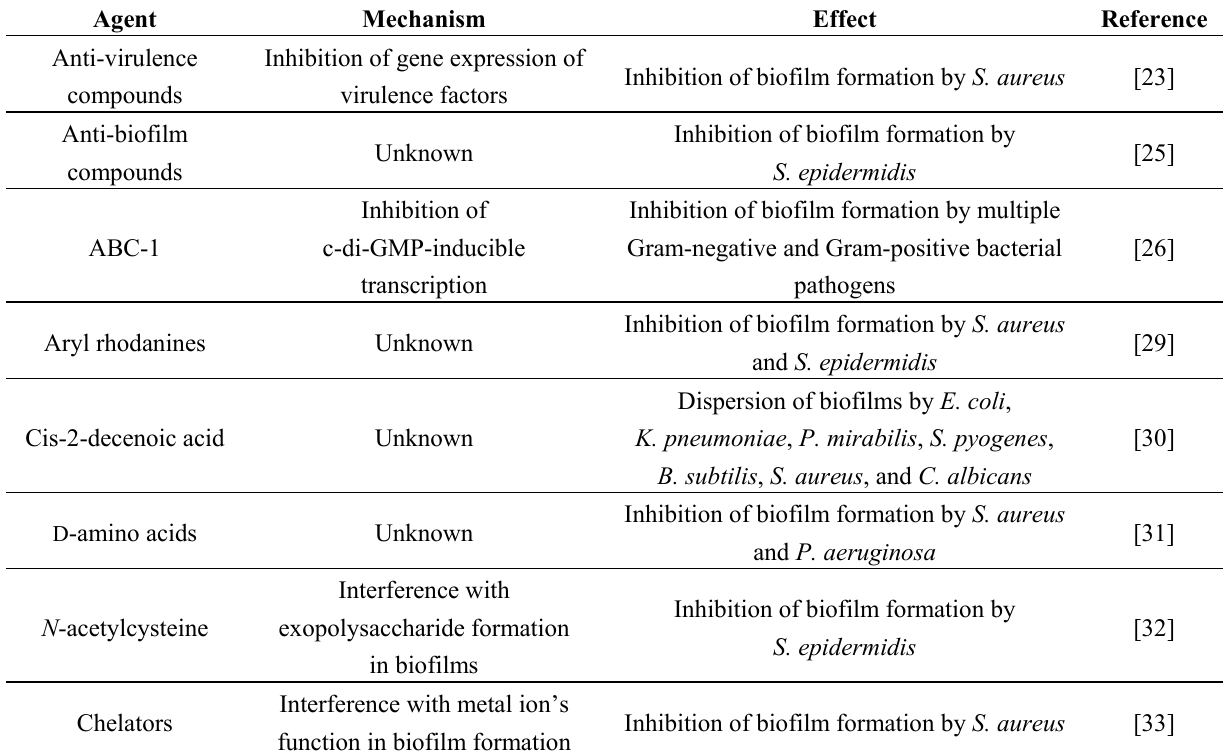
Table 1. Small molecules that can inhibit biofilm